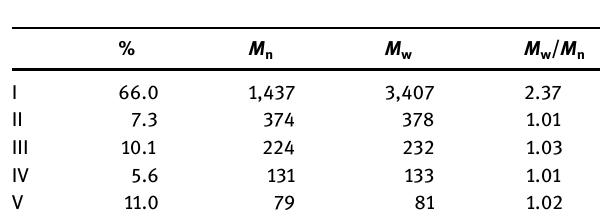
Table 1: GPC parameters of RS